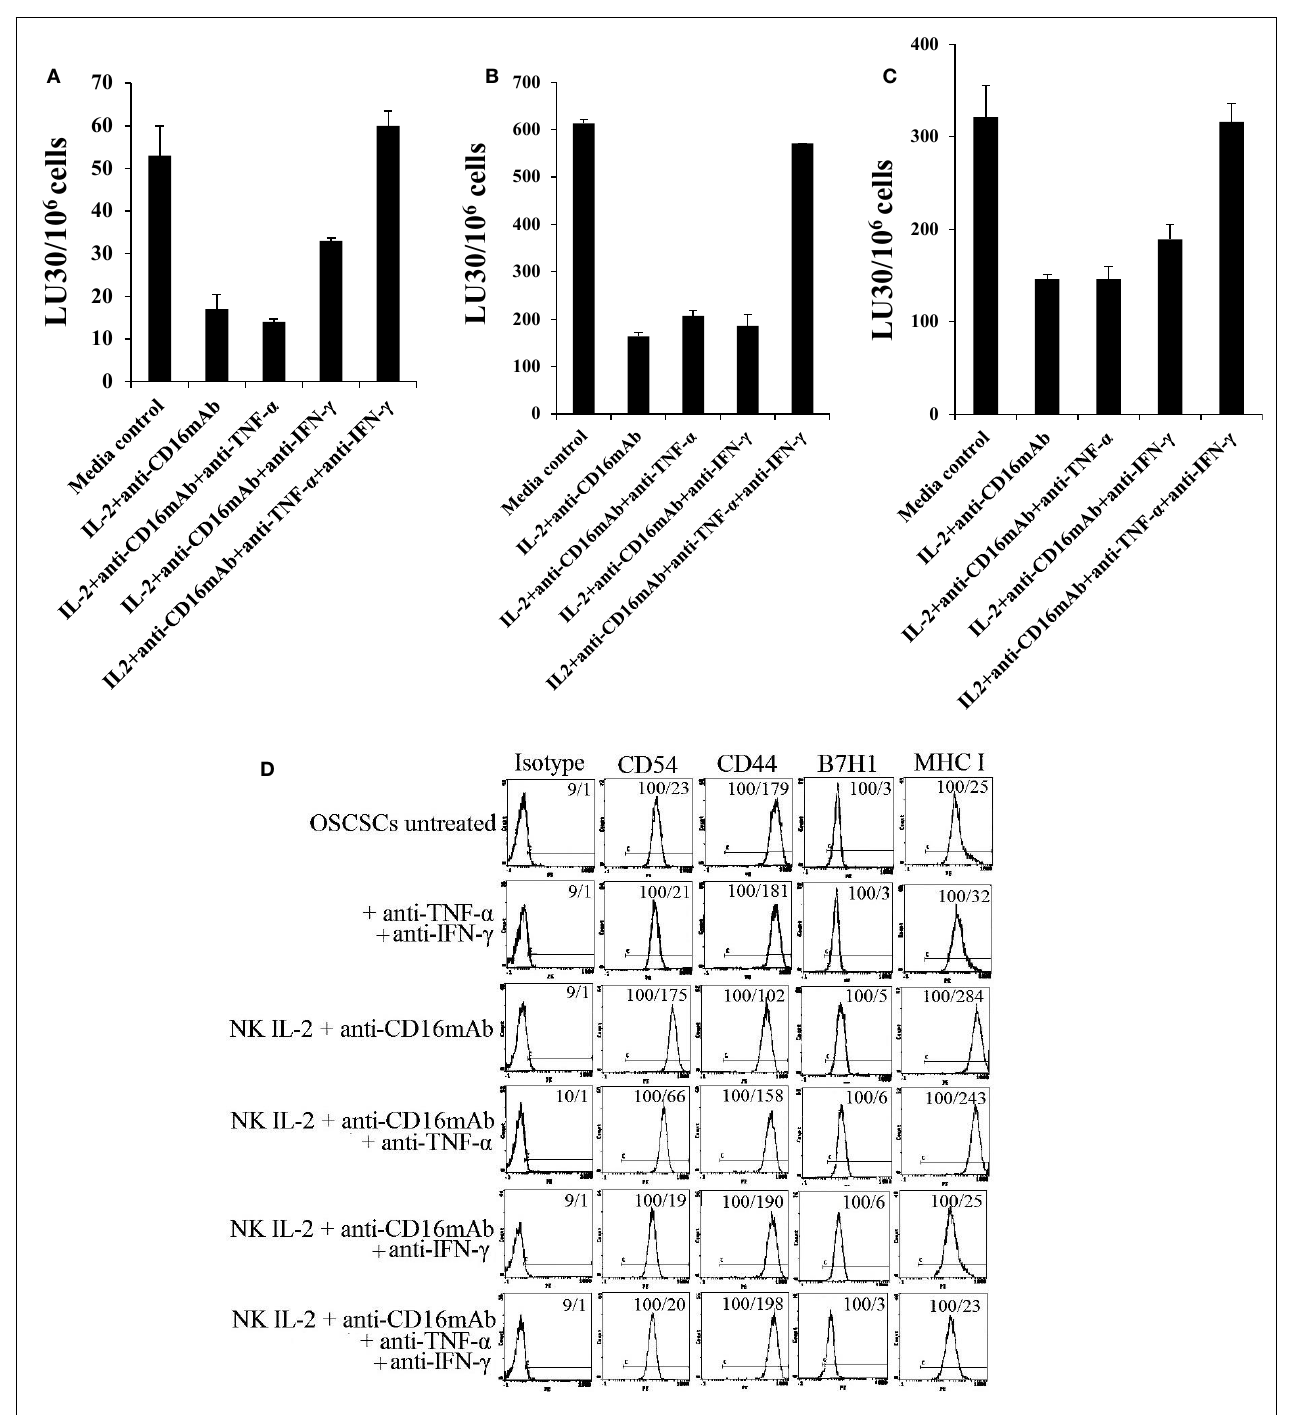
cytotoxicity against untreated and NK supernatant-treated OSCSCs in the presence of antibodies to untreated NK cells (A) , IL-2-treated NK cells (B) , or IL-2 and anti-CD16 mAb-treated NK cells (C) were assessed using a standard 4h 51 Cr release assay. Percent cytotoxicity was obtained at different effector to target ratio, and the lytic units 30/10 6 cells were determined using inverse number of NK cells required to lyse 30% of the tumor cells × 100.The surface expression of CD54, CD44, B7H1,